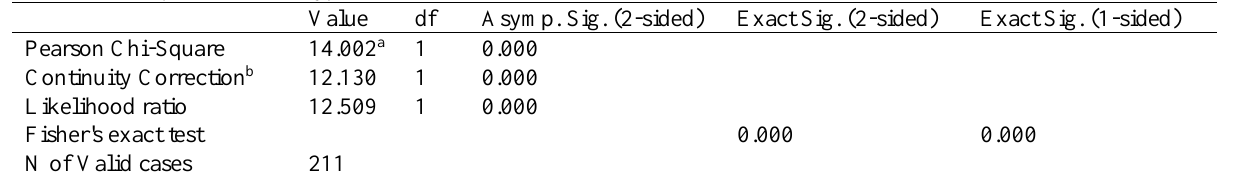
Table 5. Chi-square tests for hypothesis